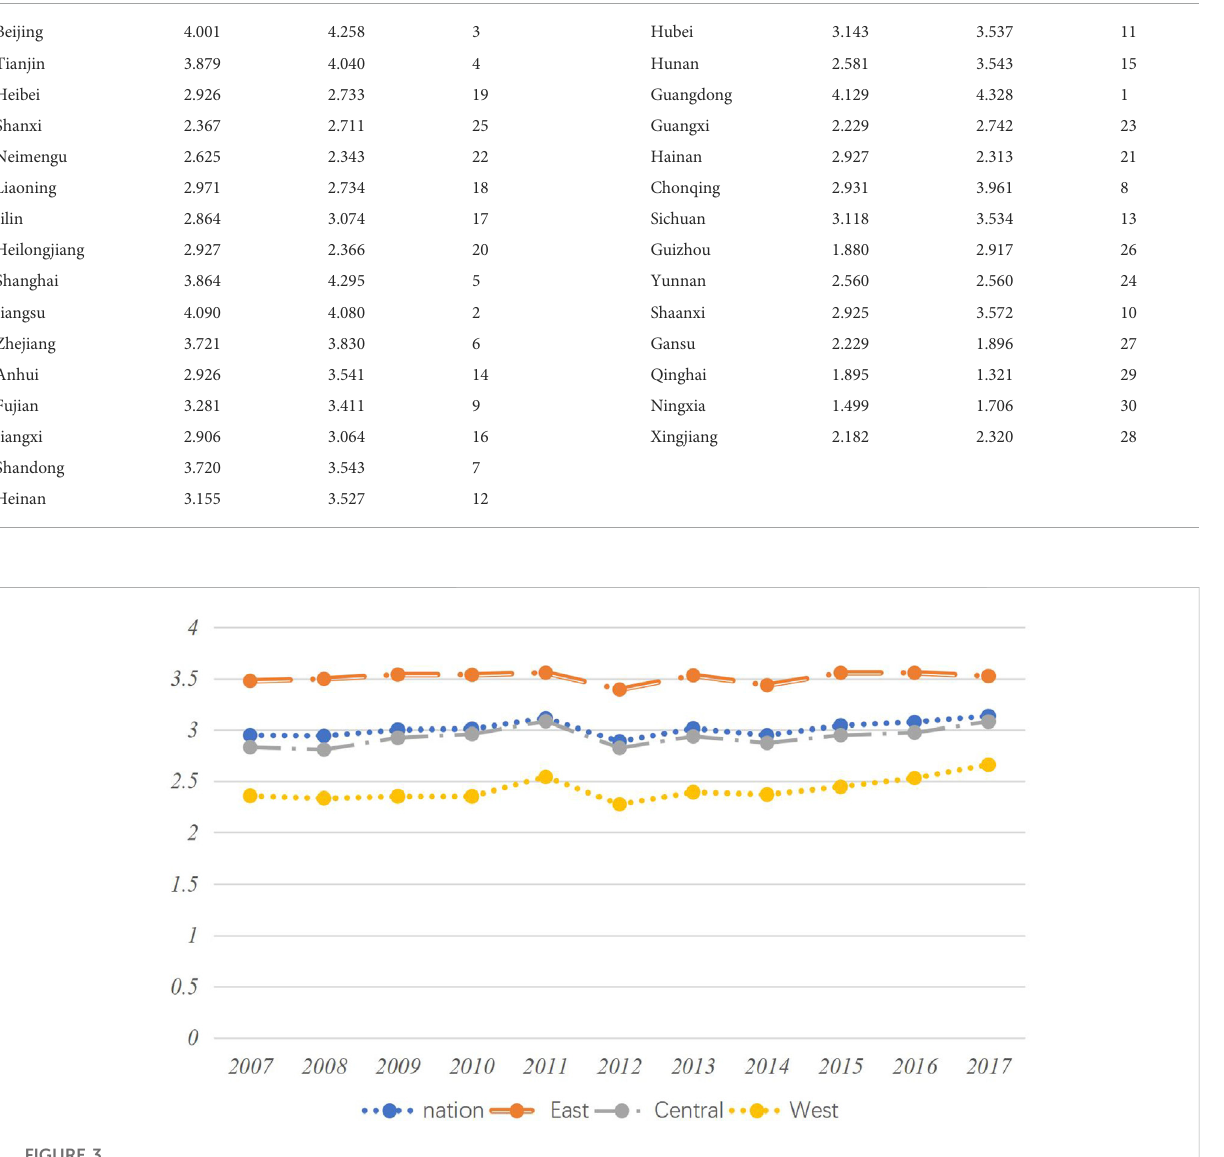
transformation. The results are shown in Table 5. The results show that: 1) China ’ s industrial green transformation gap increased from 0.1308 to 0.1435 during the period of 2007 – 2017. 2) The gap between the eastern, central and western regions of industrial green transformation expands year by year. 3) The gap between the eastern and the western regions is the largest. 4) The contribution rate of inter-regional gap to the industrial green transformation widening gap in China is always the highest. Therefore, narrowing the gap between